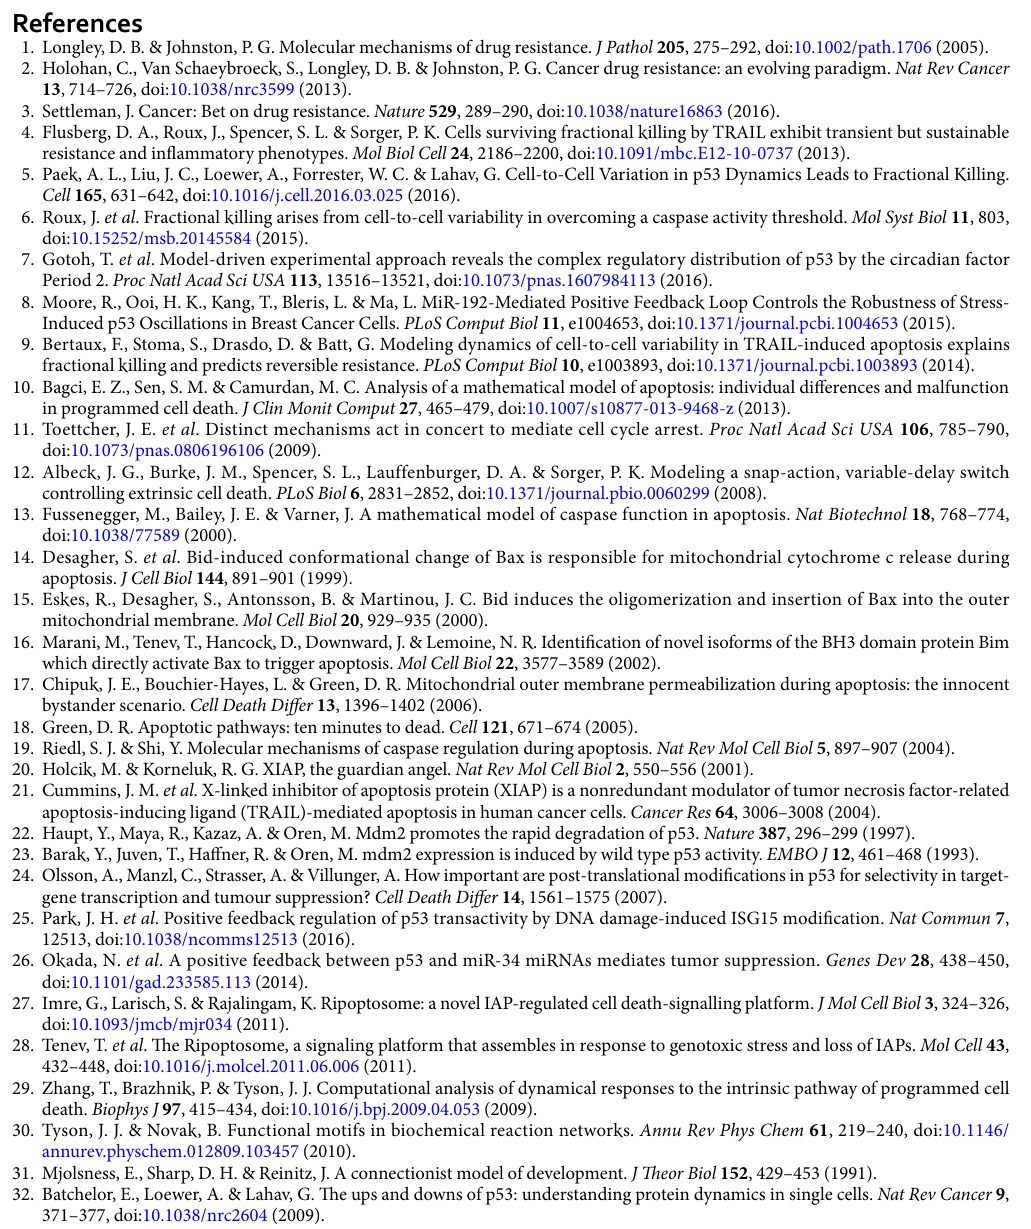
Time series simulation and dynamical analysis of the model. All model equations and parameters from Table 1 were used to compute time series simulations. Settings for drug and genetic perturbations are speci- fied in the figure legends. For one parameter bifurcation analysis, the level of p53 or the level of BH3 proteins was used as the control parameter, and the activity of BAXm was computed. For two parameter bifurcation analysis, the level of both p53 and CIAP were continuously altered, and the positions of the apoptosis initiation threshold (as well as the BAXm inactivation threshold) were computed. Computations were done using XPPAUT